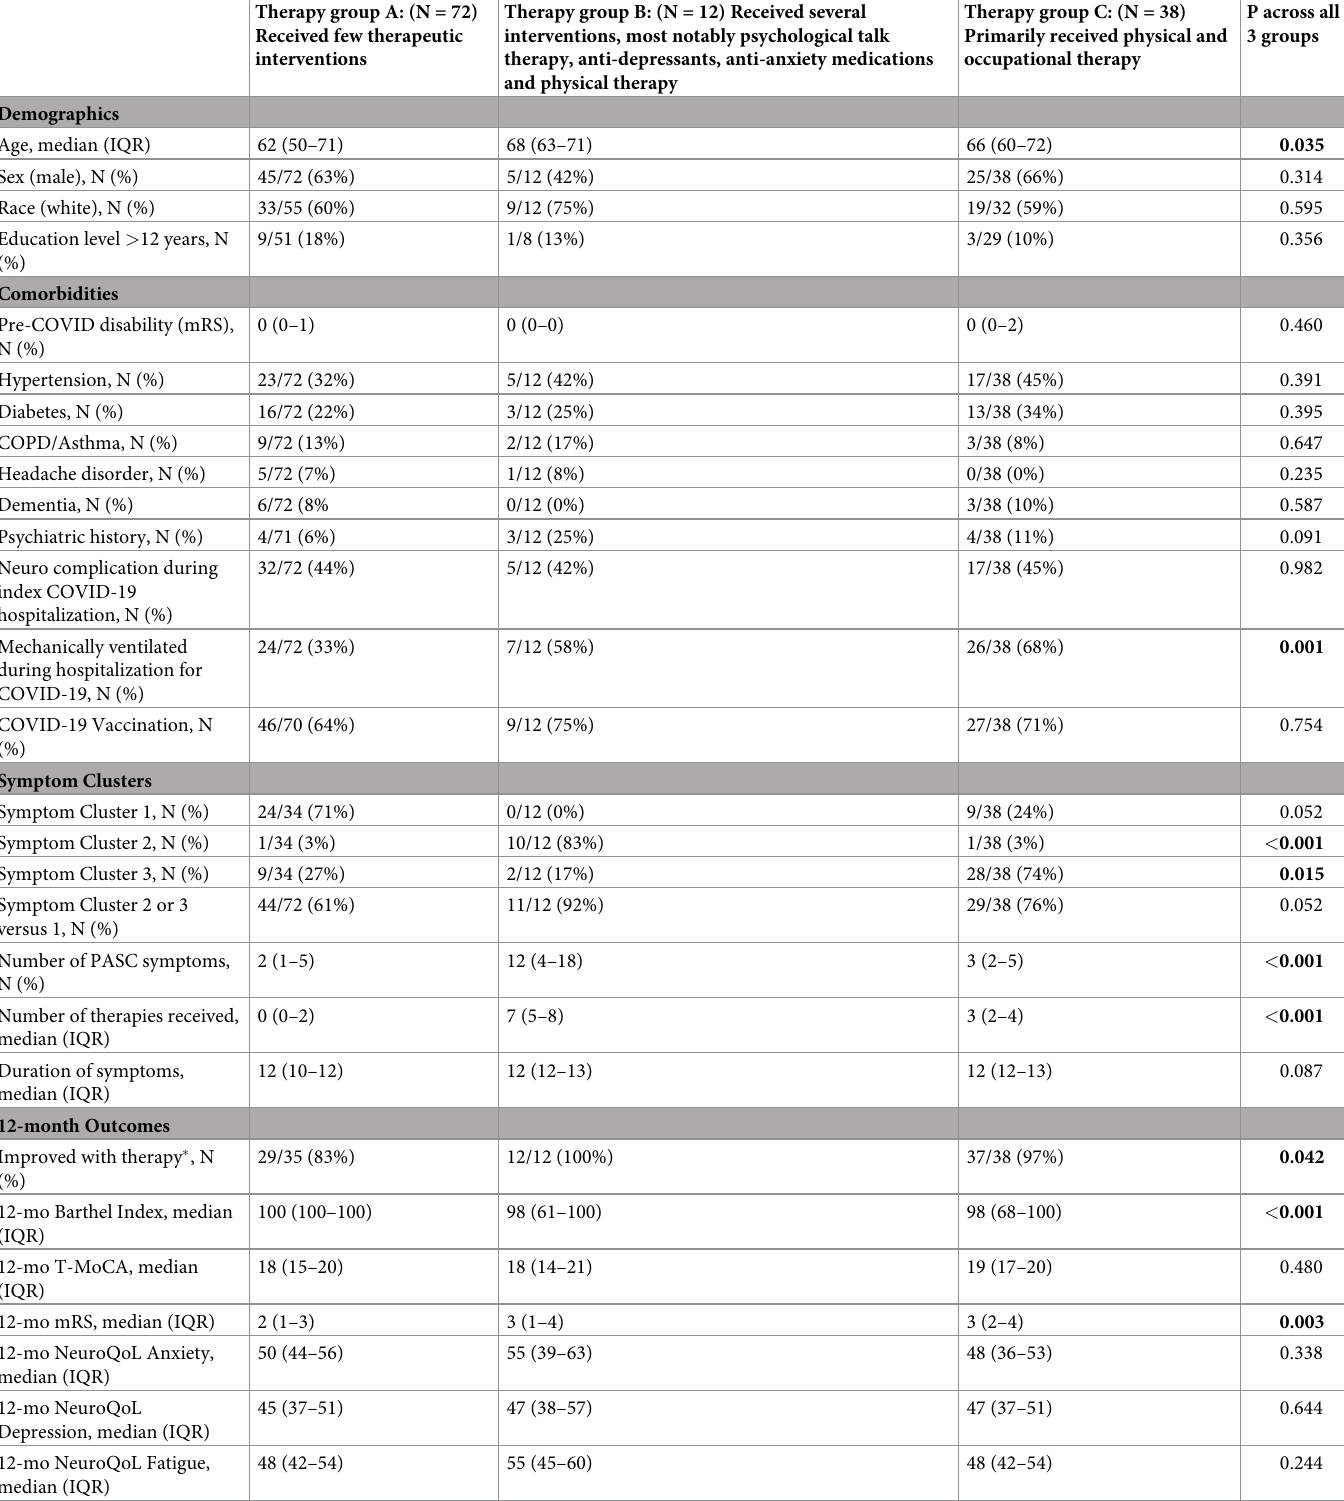
Table 2. Demographics, comorbidities, symptom clusters and 12-month outcome metrics among Therapy Groups (N = 122 PASC